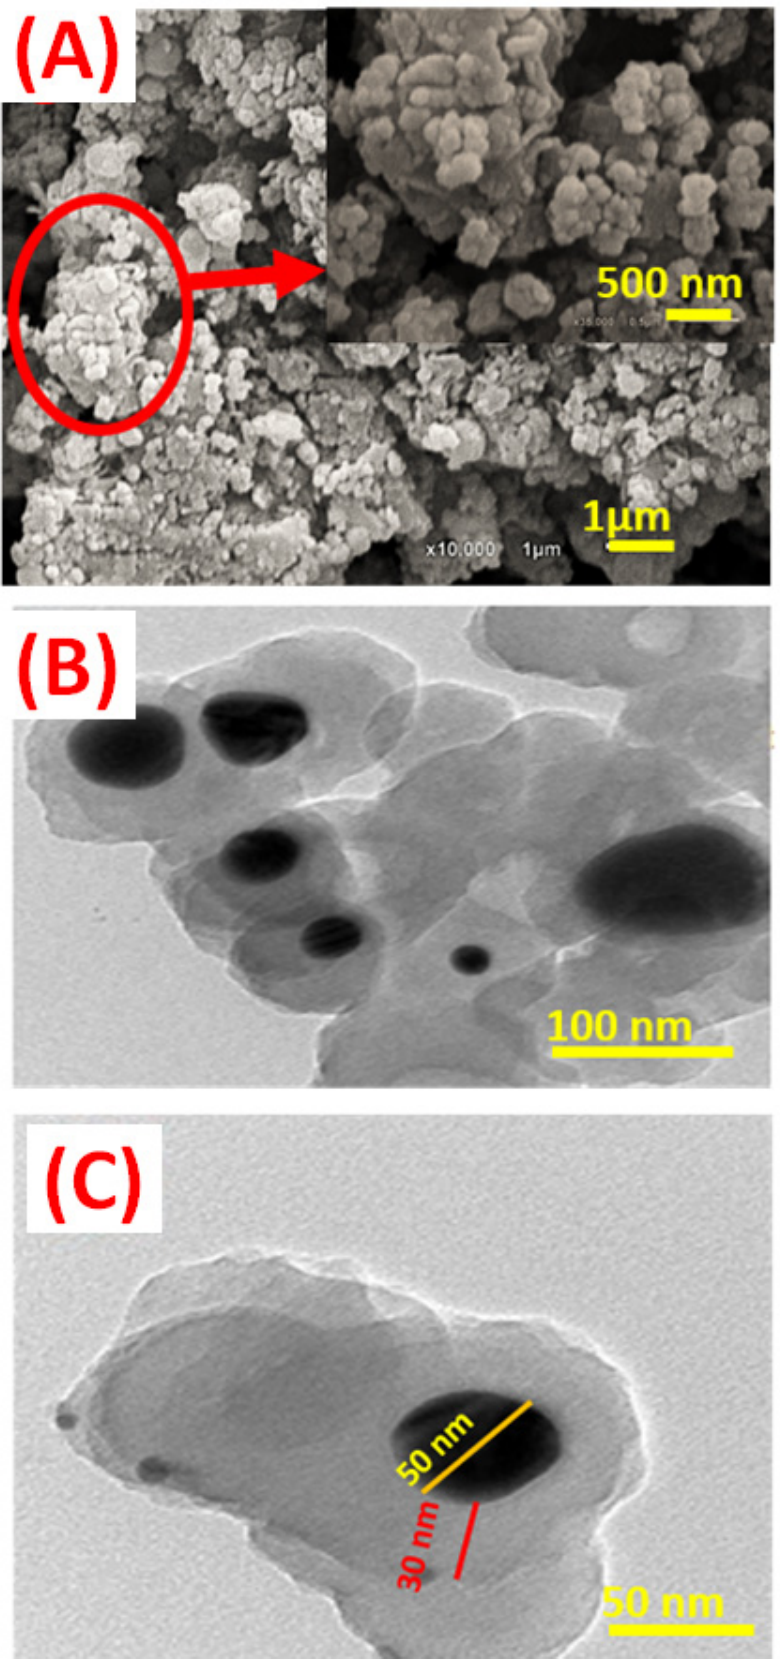
Figure 2. ( A ) SEM, ( B , C ) TEM images of the ZnO–Ag/PPy nanocomposite.